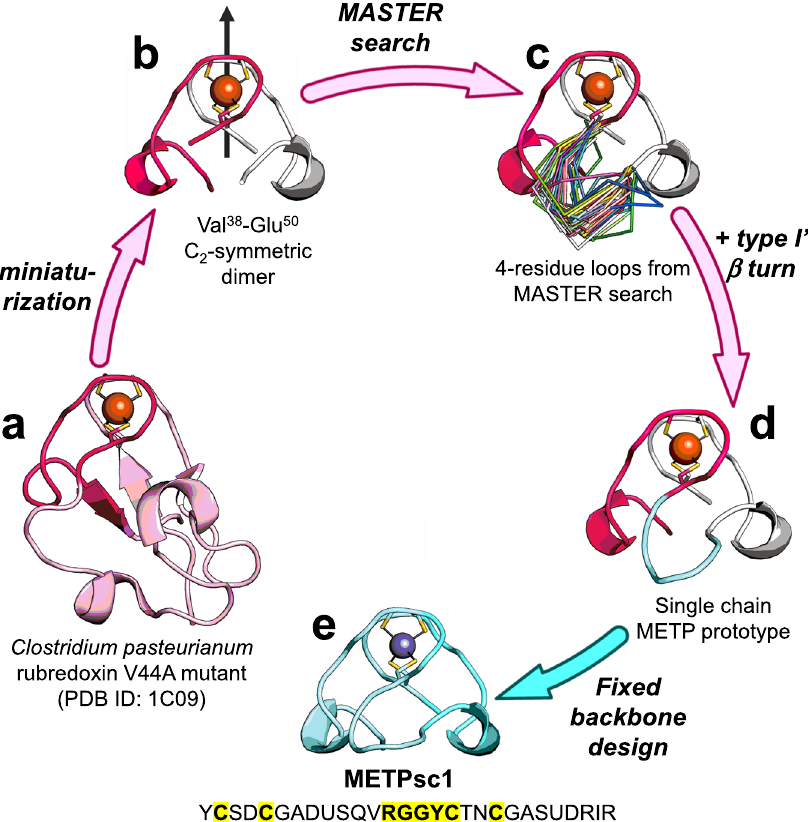
Fig. 2 | Design of METPsc1. a crystal structure of Cp Rd V44A mutant (PDB ID: 1C09). b miniaturizedmodel,obtainedbyapplyinga C 2 longitudinalrotationtothe Val38-Glu50 fragment of Cp Rd V44A. c superimposition of the 4-residue loops found from the fragment search. d single-chain METP prototype, obtained by